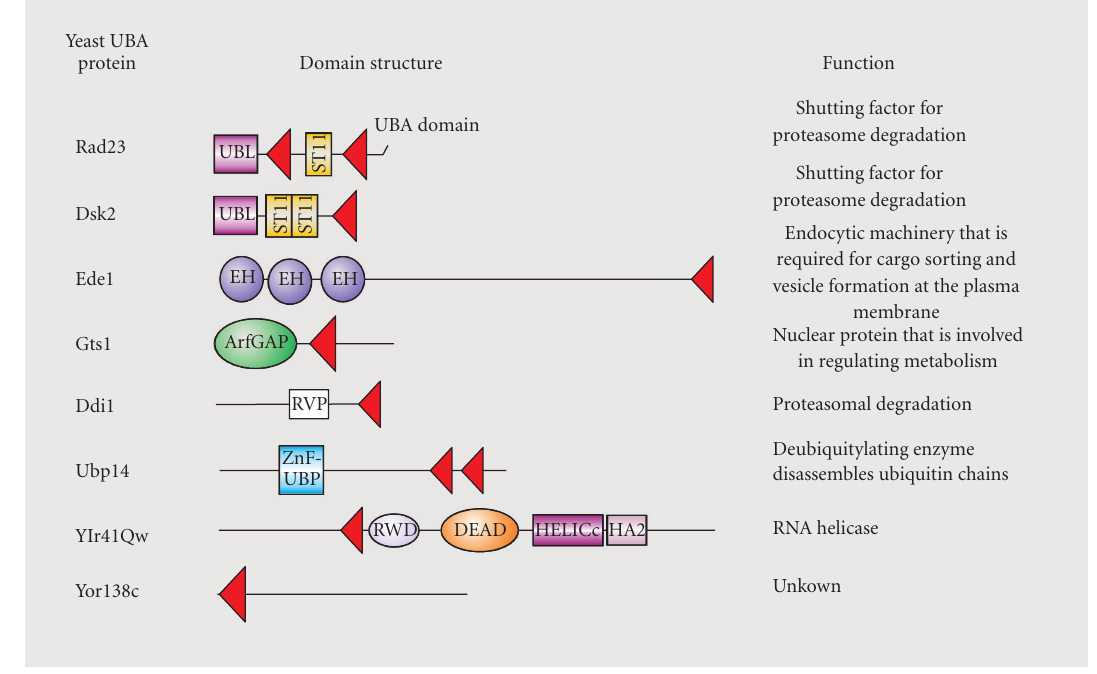
Figure 7: Proteins containing UBA domains have diverse structure and function (see [86]).